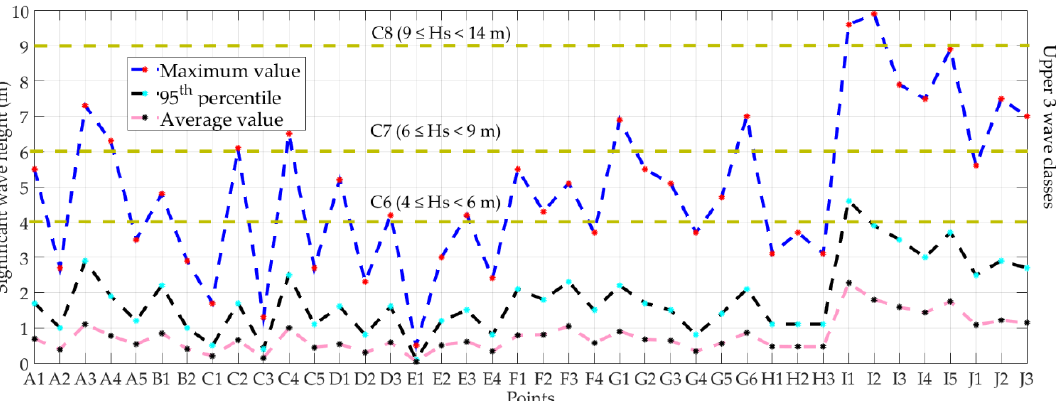
Figure 7. Distribution of the Hs wave conditions in the sites considered, for the ECMWF ERA-Interim dataset, corresponding to the time interval 1983–2017. The data were processed in terms of maximum values, 95th percentile, and average values in comparison to the upper three wind classes (C6–C8) of the Douglas Scale.